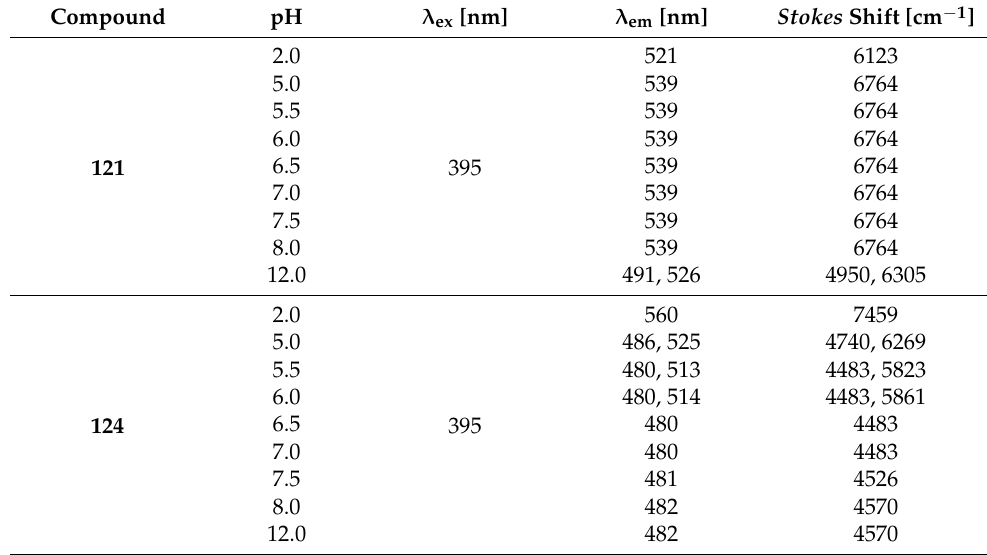
Table 21. UV-vis and fluorescent properties of indolizines 121 and 124 in aqueous buffer at different pH. Compound pH λ ex